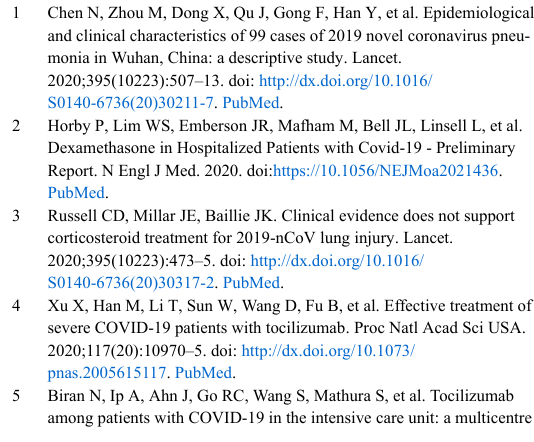
benefit of anti-inflammatory agents on short and long-term outcomes in patients with